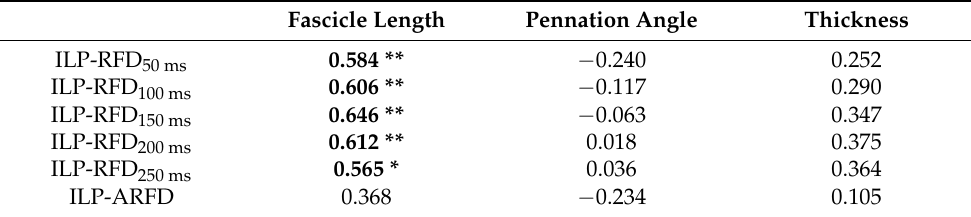
Table 4. Correlation coefficients (Pearson’s r ) between VL muscle architecture and ILP force–time characteristics (n = 19).